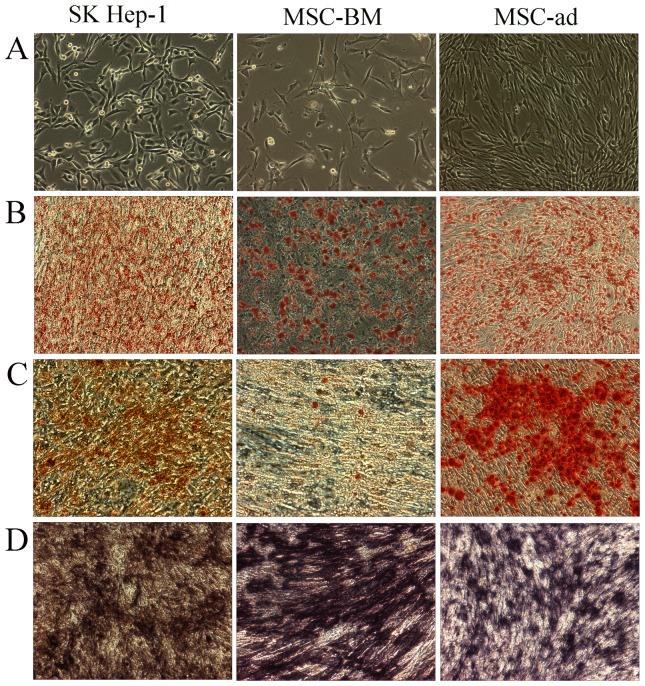
Differentiation of three cell types into adipocytes and osteoblasts.A, SK cells, adipocyte-derived MSC (MSC-ad), and bone marrow-derived MSC (MSC-BM) were used for the differentiation. B, the three cell types were differentiated into adipocytes determined by Oil Red R staining. C, the three cell types were differentiated into osteoblasts determined by Alizarin Red S staining. D, alkaline phosphatase staining was performed after the osteoblast differentiation. Magnifications: 100X